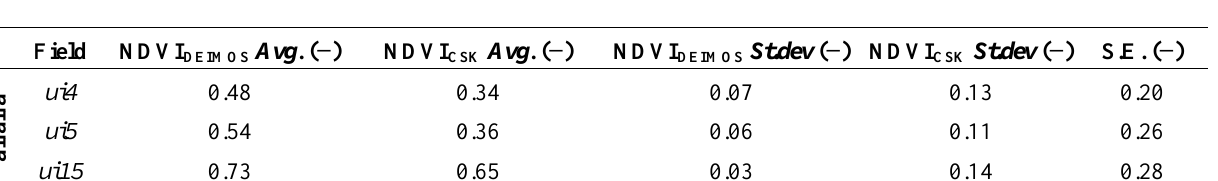
Figure 8. NDVI time series over corn (( a ), field ‘ ui11 ’) and alfalfa (( b ), field ‘ ui15 ’).